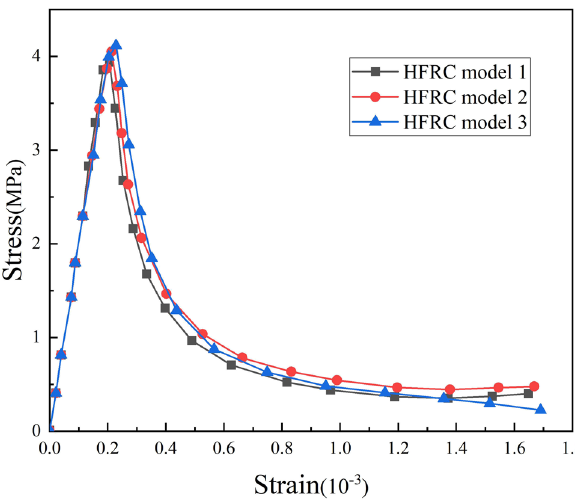
Figure 8: Stress – strain relationship curve of the hybrid fi ber con - crete model with di ff erent distributions.